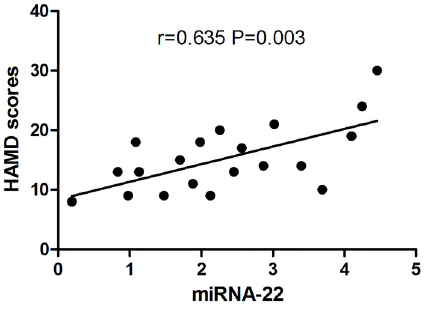
Figure 3. Pearson ’ s correlation analysis between the relative expression of plasma miR-22 and Hamilton depression (HAMD) score in post-stroke depression patients.